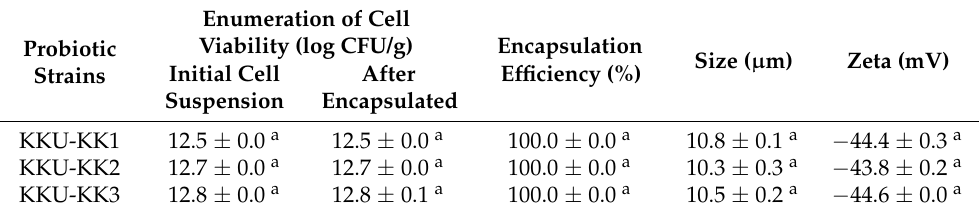
Table 3. The cell viability of the initial and later encapsulated probiotic starters and their encapsulation efficiency for maintaining cell survival using the freeze-drying technique. Enumeration of Cell Viability (log CFU/g) Encapsulation Probiotic Size ( µ m) Zeta (mV) Efficiency (%) Initial Cell After Strains Suspension